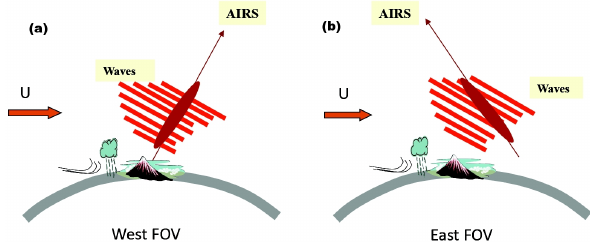
Fig. 1. Cartoons showing the wave smearing effect from different views. (a) Westmost off-nadir view, where in this particular case wave signals are largely smeared out; (b) Eastmost off-nadir view, where the strongest variance should be observed. Red parallel rect- angles represent the phase lines of the GW, while bold red arrows denote the mean wind direction.